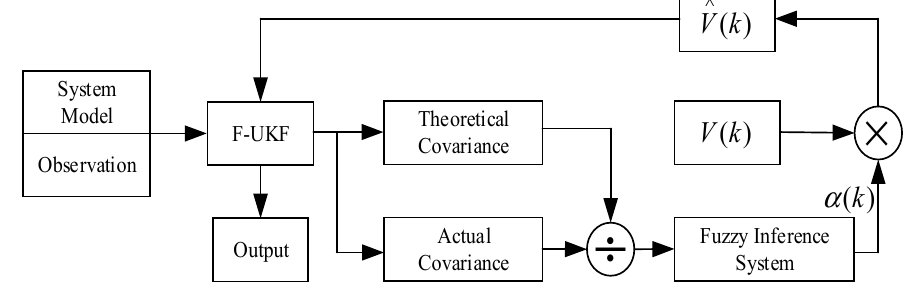
Figure 6. Structure diagram of the fuzzy controller.